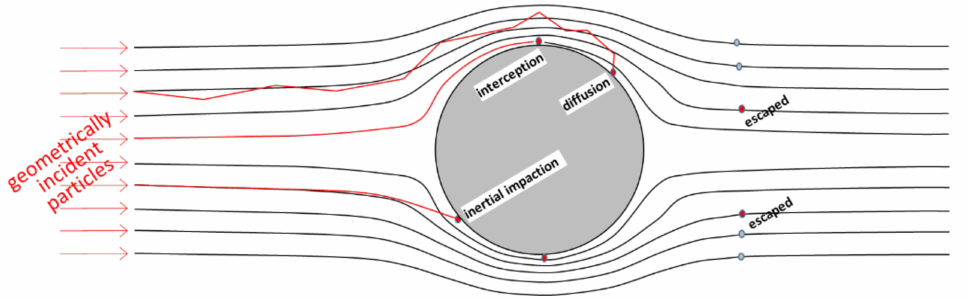
Figure A4. Particle deposition